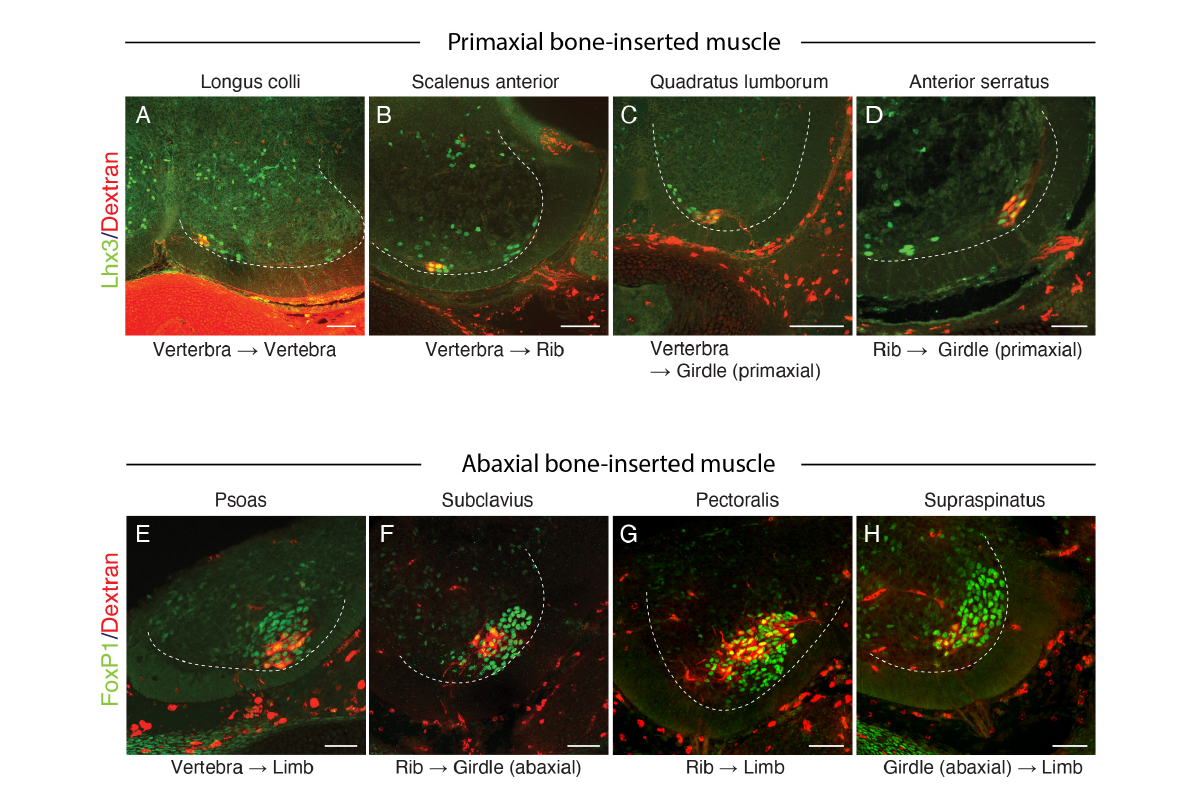
FIGURE6 Lhx3 and FoxP1 expressions in MNs innervating muscles spanning various skeletal elements. Lhx3 expression (A–D) (green nuclei) and FoxP1 ( E,H , green nuclei) in labeled MNs (red) following the injection of the tracer (Alexa594-labeled dextran) into the target muscles. The ventral quadrant of the brachial and lumbar spinal cord from E13 (A–C,E–H) or E15 (D) mouse embryos are shown, and the dashed lines mark the ventral horns. In all micrographs, the midline and the dorsal side are located toward the left and top of the image, respectively. Scale bars, 100 µ